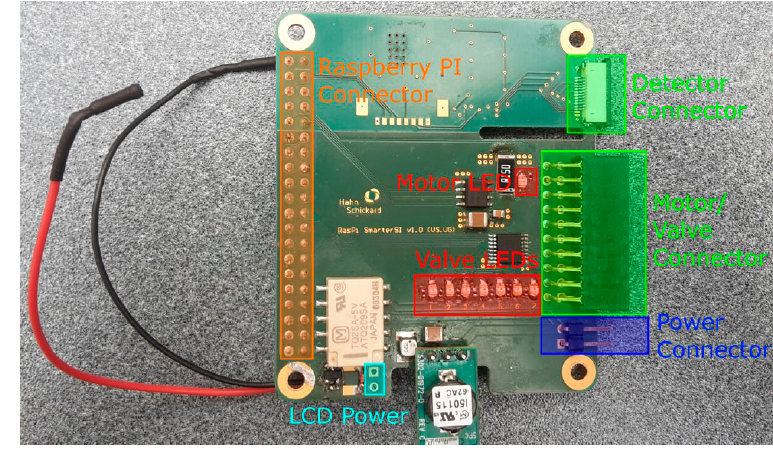
Figure 2. Designed driving